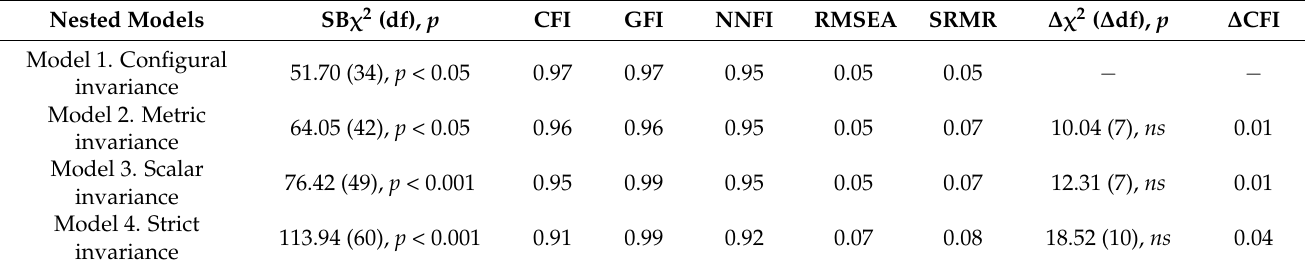
Table 4. Fit indexes for invariance factor